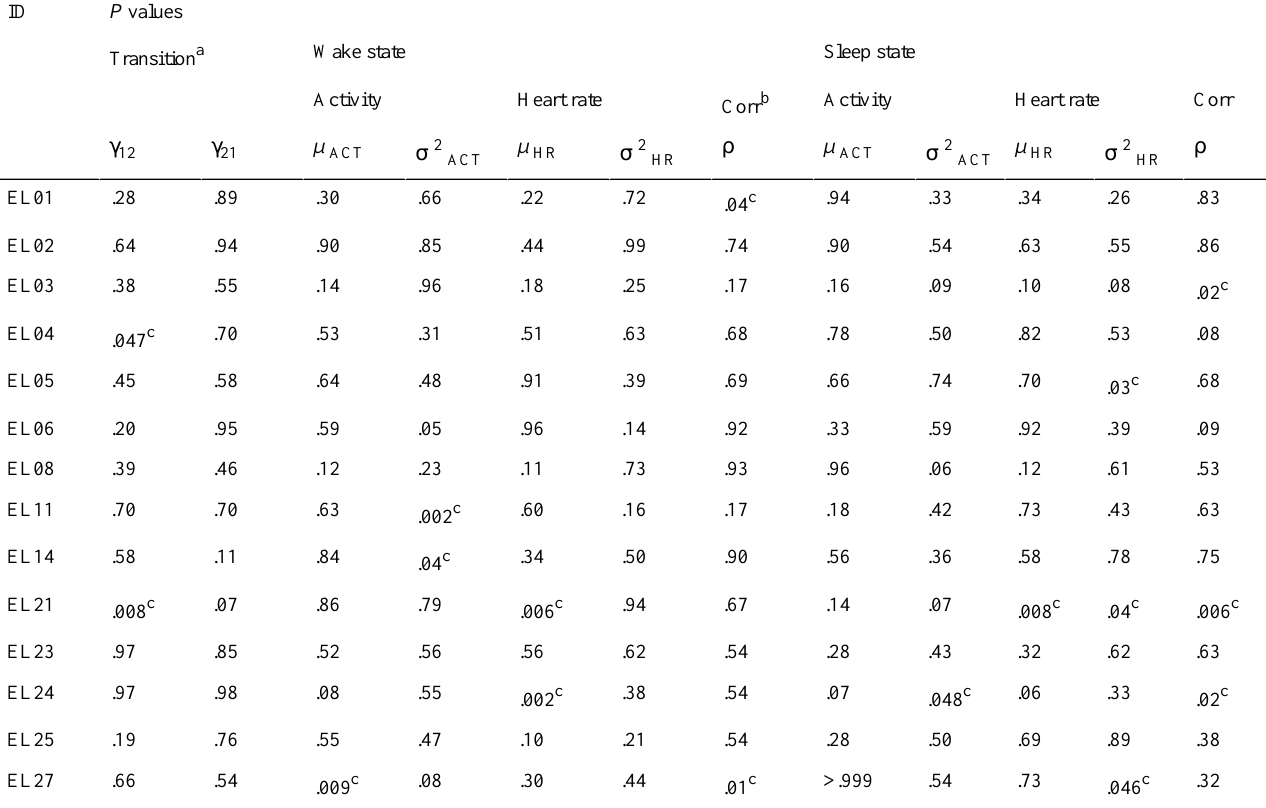
Table 5. P values for t tests on estimated parameter values for weekday and weekend for each participant. P